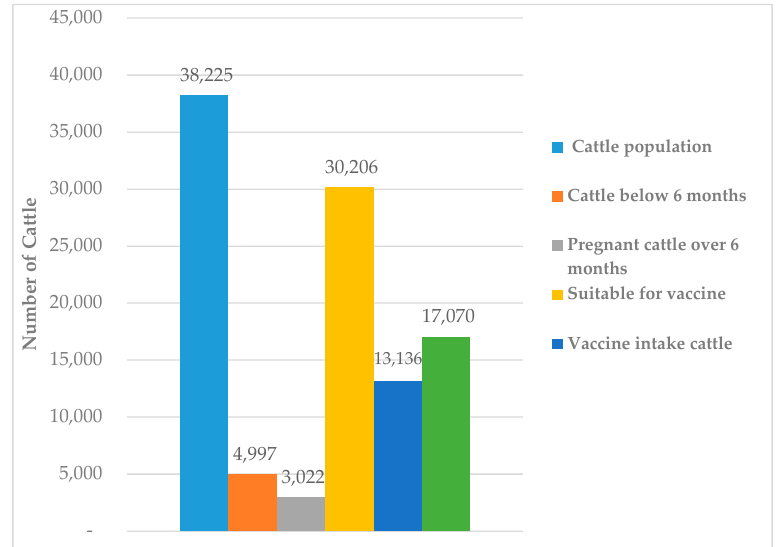
Figure 2. The cumulative Livestock census and coverage of vaccine intake during vaccinations in the present study. Table 1. The Livestock population and average vaccination intake in different study locations.